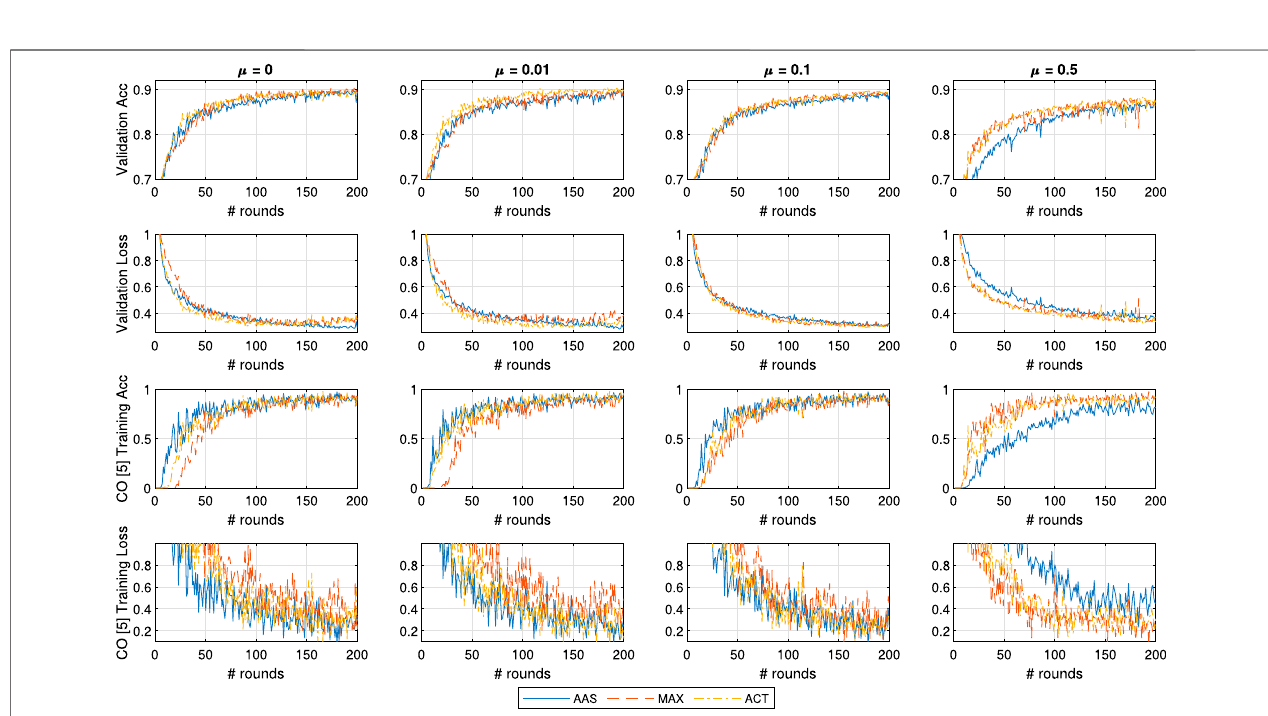
FIGURE 7 | General and CO-speci fi c accuracy and loss results obtained when testing, with an extra CNN layer, all three methods in combination with FedProx using the FMNIST dataset.